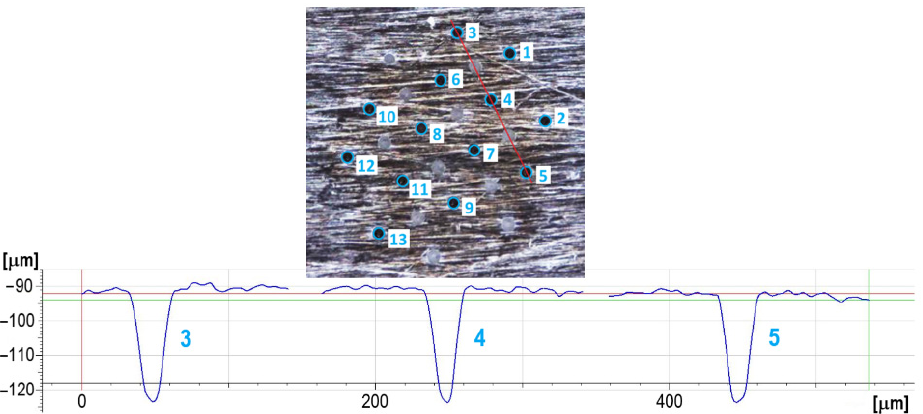
Figure 4. Representative images of a top scan performed by optical 3D microscopy on the milled side of the T91 sample showing the 13 membranes in blue (top). Line profiles of three selected wells (numbers 3, 4, and 5) used to measure the depth of the wells (bottom).